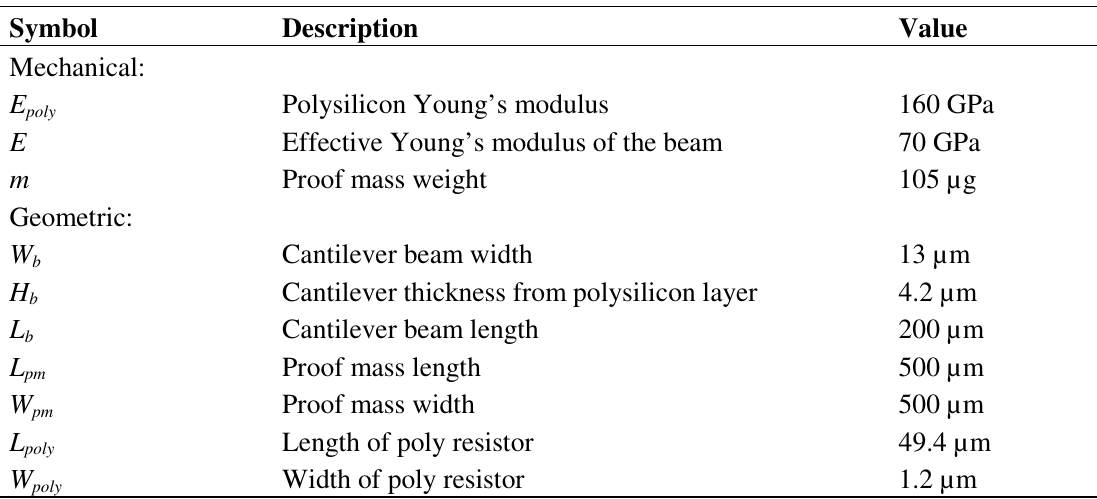
Table 2. Sensor Dimension and Material